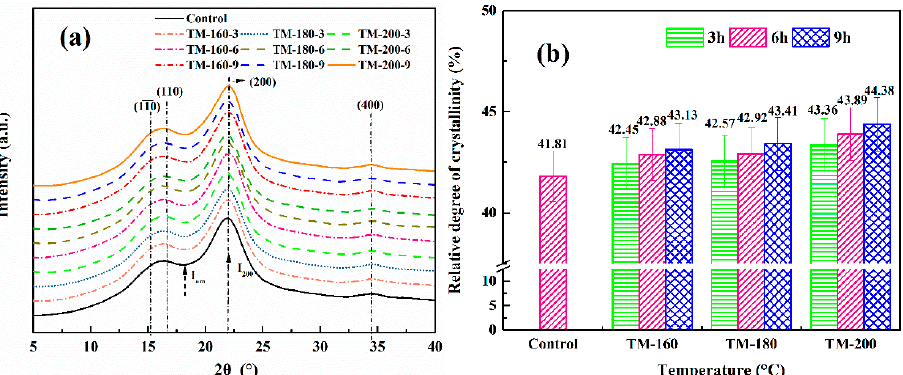
Figure 3. XRD analysis of the control and thermally-modified wood: ( a ) the XRD spectra; ( b ) the crystallinity index (CrI).